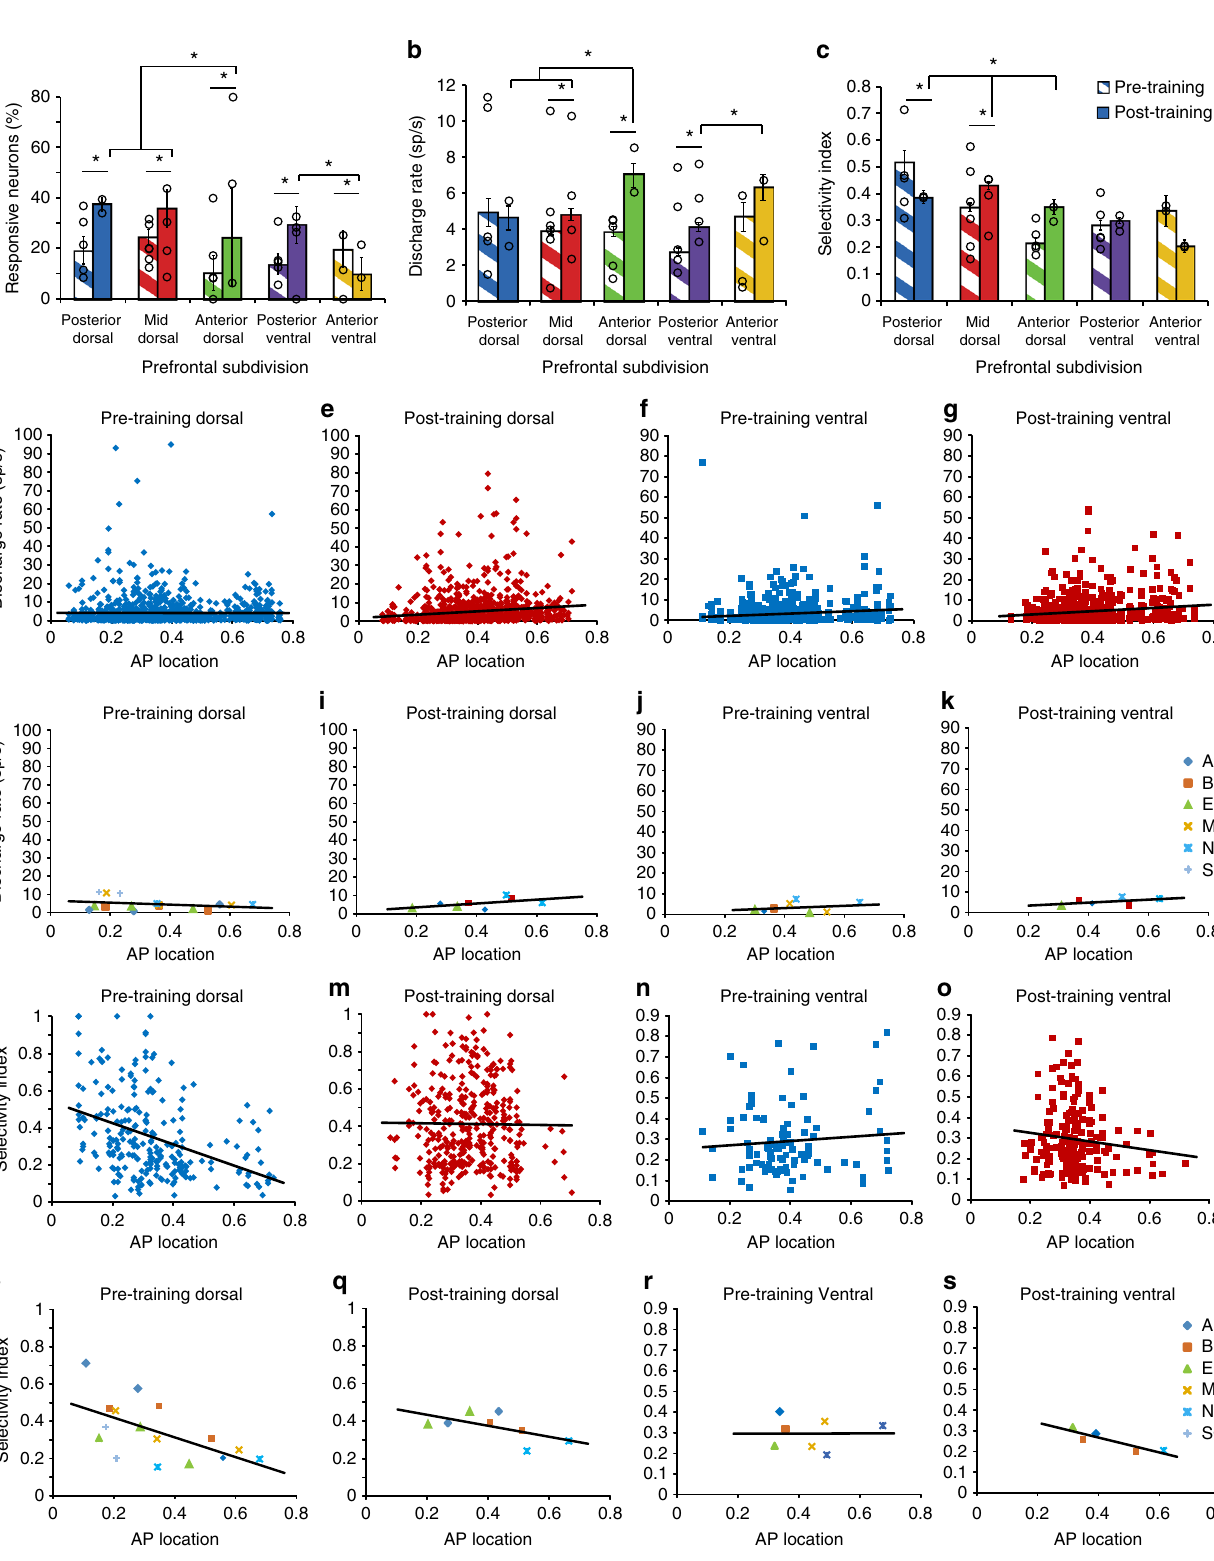
more anterior parts of the prefrontal cortex (Fig. 3d, e). Prior to training, fi ring rate did not vary appreciably as a function of dorsal AP location (Fig. 3d), as evidenced by a slope of a regression line that was not signi fi cantly higher than zero (F 1,1206 = 0.03, r = 0.002, p = 0.872). On the contrary, after training (Fig. 3e) the slope of the regression line was highly